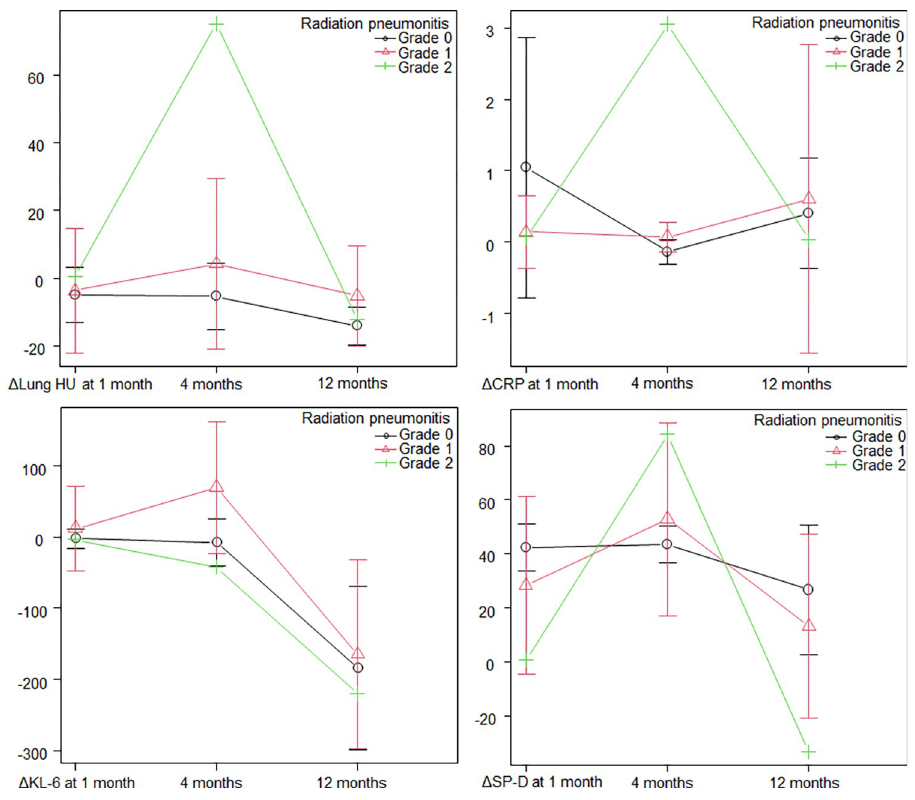
Fig 1. Changes in the mean HU of the whole lung, CRP, KL-6 and SP-D from baseline to the 1-month, 4-month and 12-month follow-ups according to radiation pneumonitis. Although Δ mean HU of the whole lung, Δ KL-6 and Δ SP-D peaked at 4 months, Δ KL-6 in the patients with grade 2 radiation pneumonitis was decreased at 4 months.